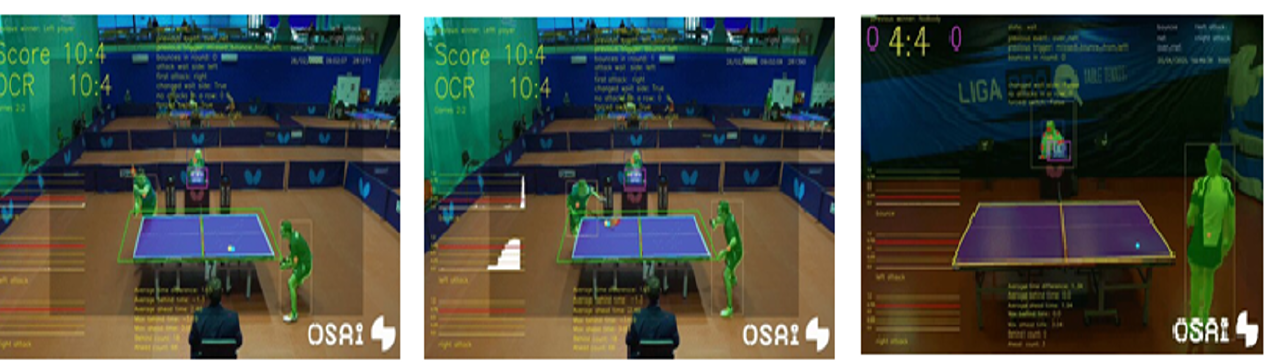
Figure 12. Instances from the TTNet dataset